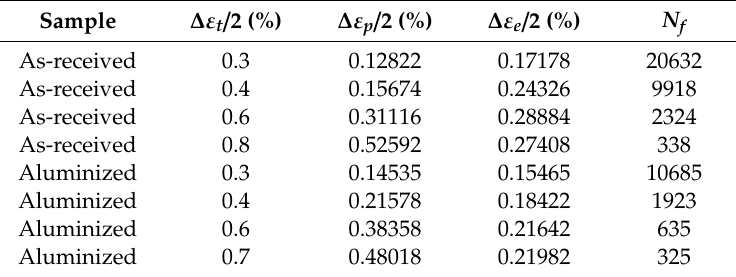
Table 5. Summary of LCF fatigue tests results.